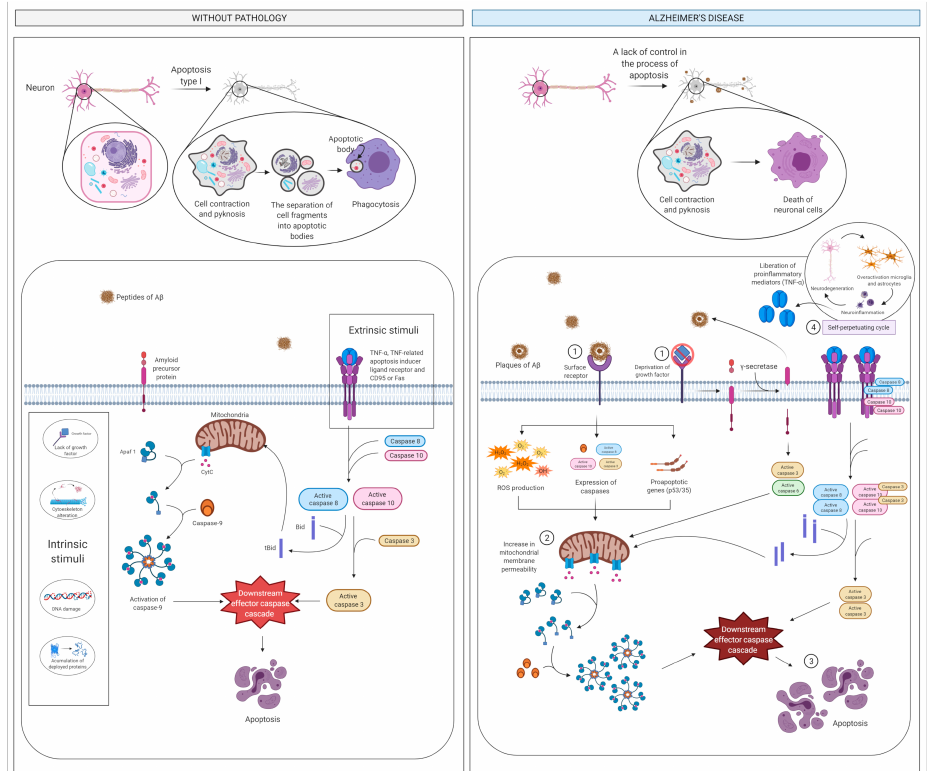
Figure 4. Apoptosis and cell death pathway. In the intrinsic pathway, the interaction of A β plaques with surface receptors of the neuron (step 1) results in ROS generation and expression of caspases and proapoptotic genes. In the extrinsic pathway A β produces a stimulus resulting in the activation of caspases. Both pathways produce an increase in mitochondrial permeability (step 2) and provokes the neuronal apoptosis (step 3) and therefore the activation of the self-perpetuating cycle (step 4). Abbreviations: A β , amyloid beta; Apaf 1, apoptotic protease-activating factor 1; CD95, cluster of differentiation 95; CytC, cytochrome C; H 2 O 2 , hydrogen peroxide; O 2 − , oxide; ROS, reactive oxygen species; t-Bid, truncated bid protein; TNF, tumor necrosis